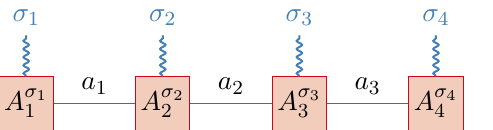
Figure 3: Pictorial representation of a matrix product state. The corresponding math- ematical description is detailed in (134). Physical indices / legs are drawn as wavy lines while virtual indices / legs are straight.